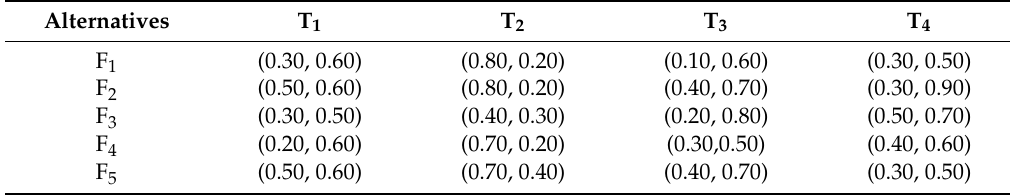
Table 8. Pythagorean fuzzy matrix by DM 3.